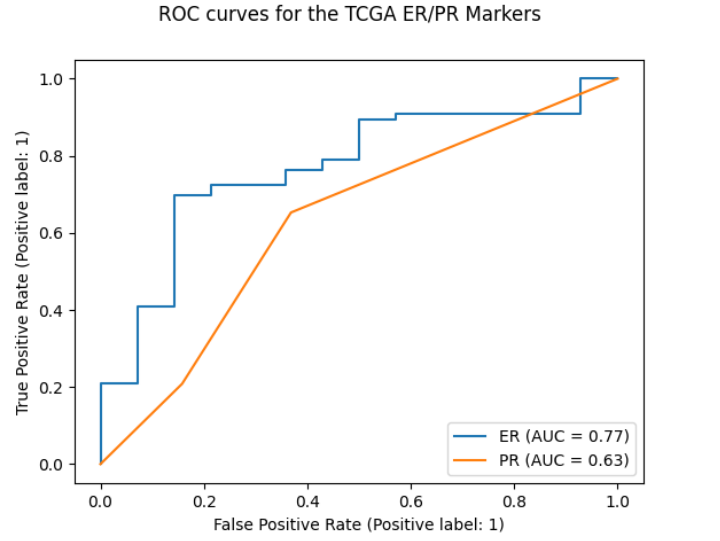
Figure 5. ROC curves and Area Under the Curve (AUC) for the ER and PR markers on the DS T validation dataset. Table 7. Selected features at the end of the two-step pipeline for the four biomarkers.